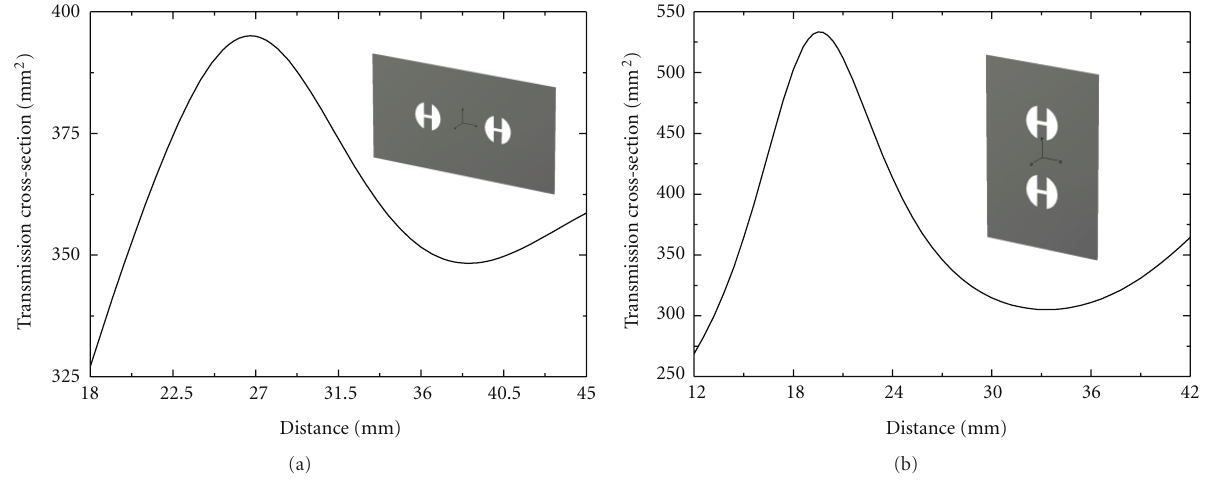
Figure 2: TCS versus center-to-center distance for (a) case B (collinear case) and (b) case C (side-by-side case).